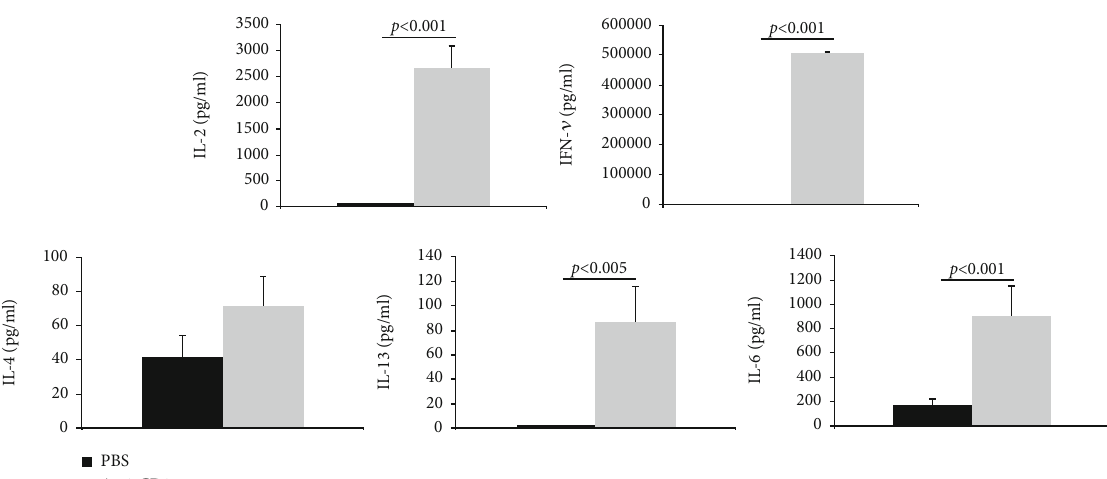
Figure 5: The cytokine secretion pro fi les of HPBLs after stimulation. Three days after stimulation by immobilized anti-CD3 mAb, the cell culture suspensions of HPBLs were collected. After centrifugation, the supernatant was transferred into new tubes. Di ff erent cytokine levels in the supernatant were measured with ELISA kits. The values represent the meanvalue ± SD of samples from a minimum of 7 healthy donors in each